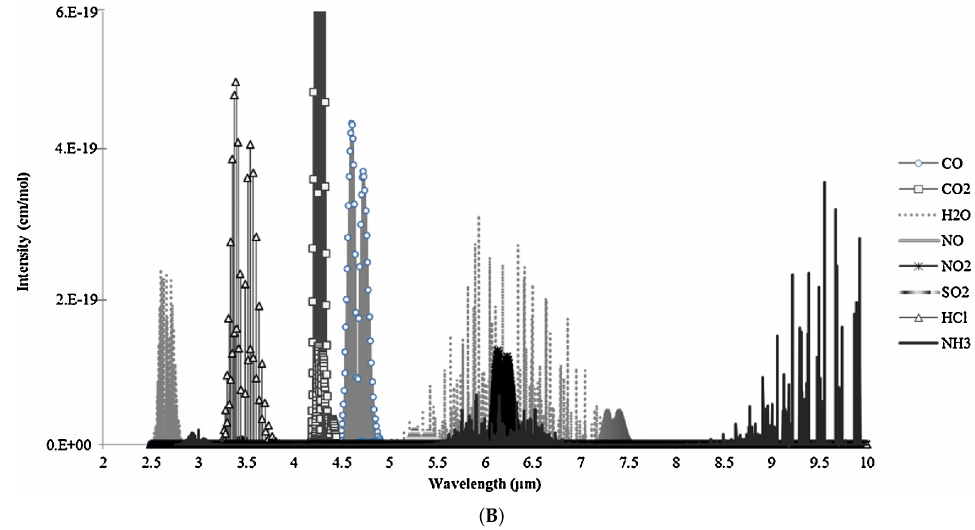
Figure 4. ( A ) Schematic of typical NDIR sensor for gas detection. ( B ) Infrared absorption features for several gases. [Reprinted with permission from ref.